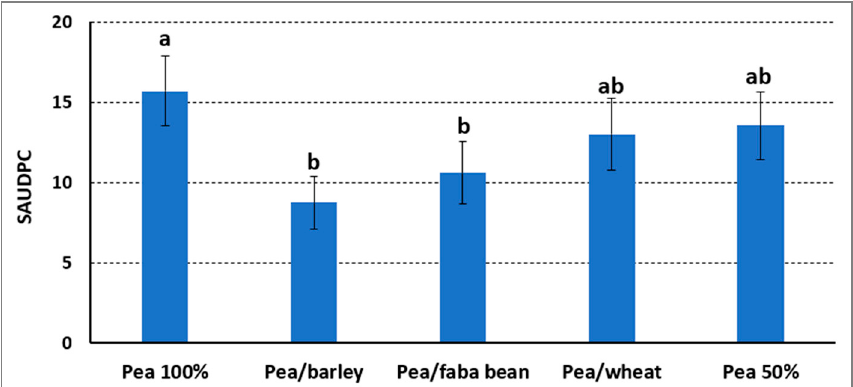
Figure 4. Standardized area under disease progress curve (SAUDPC) for severity of powdery mildew in pea in the different treatments evaluated across the six intercropping field trials. Different letters mean significant differences (Dunn’s test corrected by Bonferroni, p < 0.05). Bars for standard errors are shown.